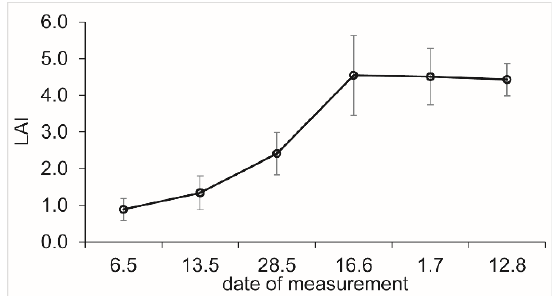
Figure 3. Seasonal changes of LAI on ten-year-old windthrow, between May and August 2014; the dots represent means from 25 plots, and the whiskers show SD.